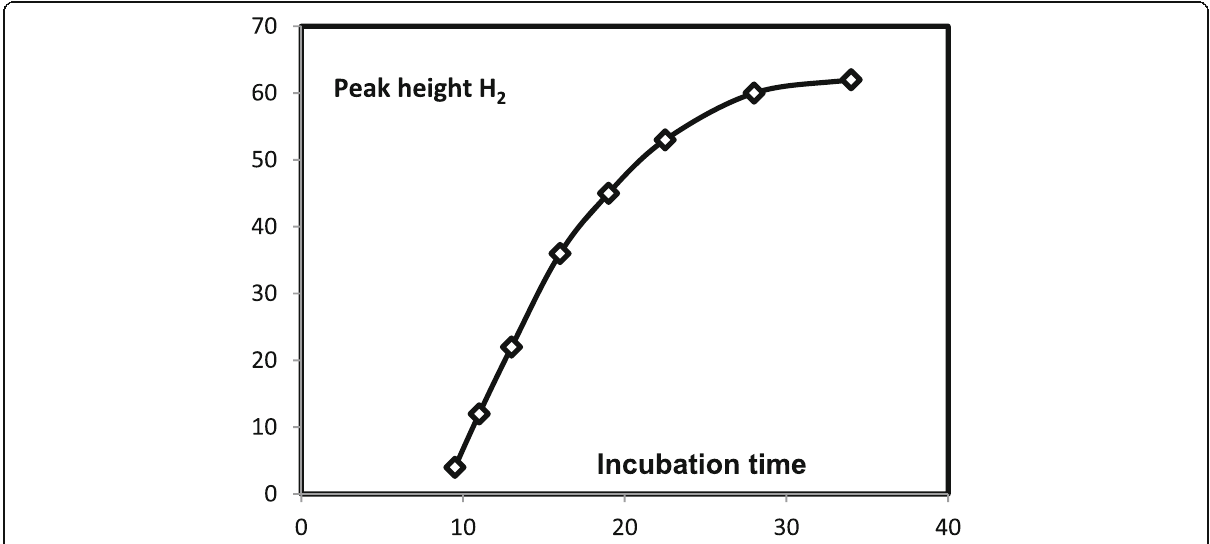
Fig. 1 Incubation times (hours) for bacterial analysis from a smear taken from a kitchen cloth. Peak heights in arbitrary units. GC-column 1: silica